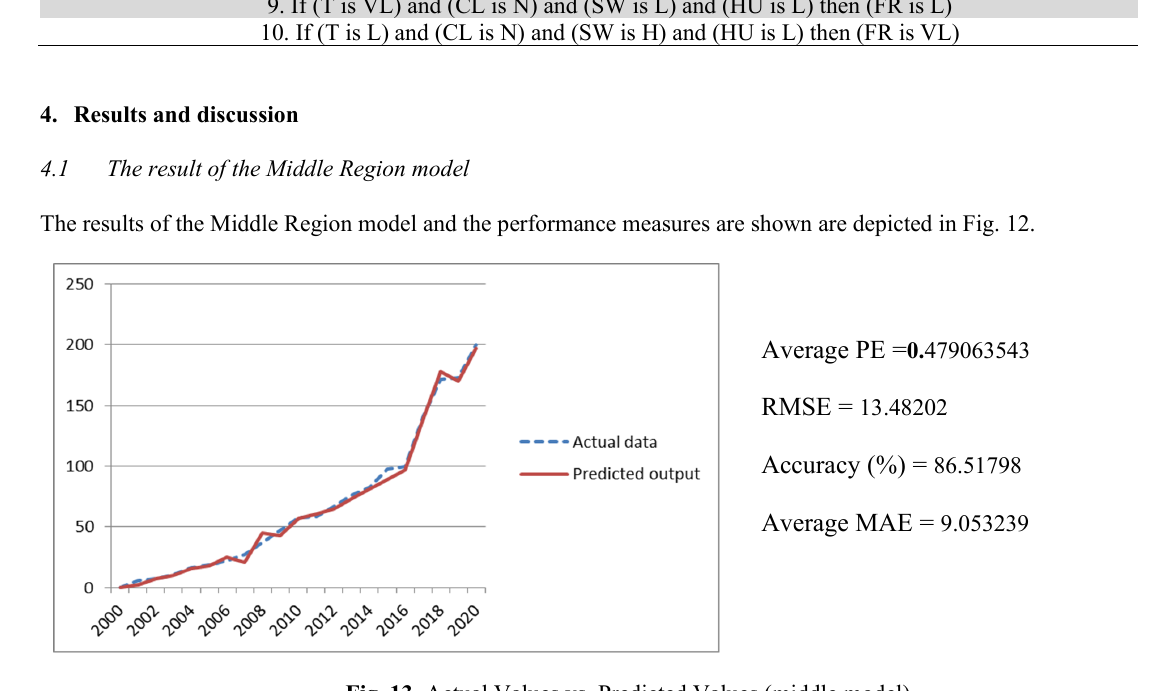
Fig. 13. Actual Values vs. Predicted Values (middle